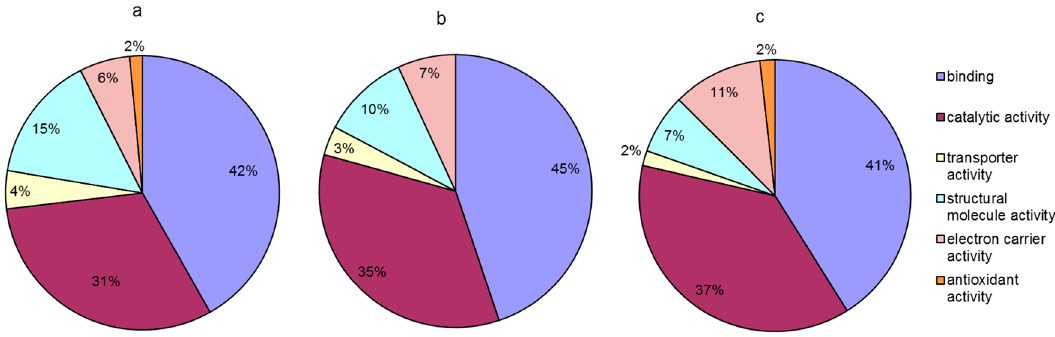
Figure 5. Molecular function of differentially abundant proteins under temperature stress. ( a ) Proteins responding to rapid increase in temperature (5–20 ◦ C); ( b ) proteins responding to rapid decrease in temperature (20–0 ◦ C); ( c ) proteins responding to the entire temperature treatment (5–20–0 ◦ C).